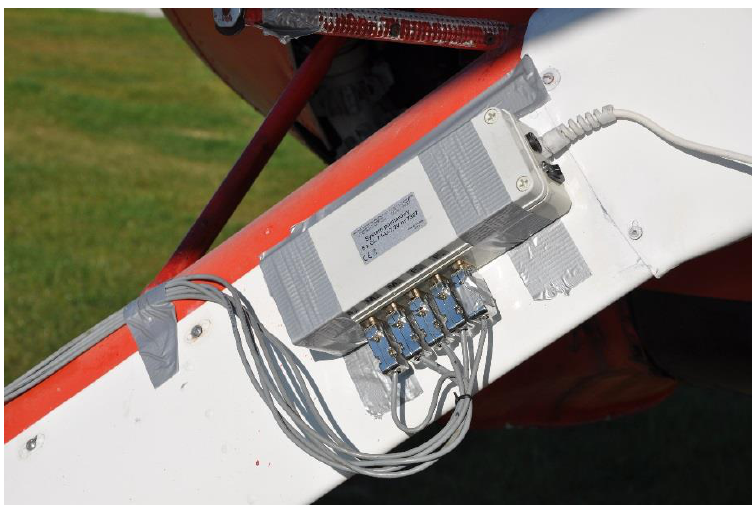
Figure 6. The electronics: Signal amplifiers and wireless data transfer system in the box, installed on the landing gear leg (a silver tape was used for quick installation).